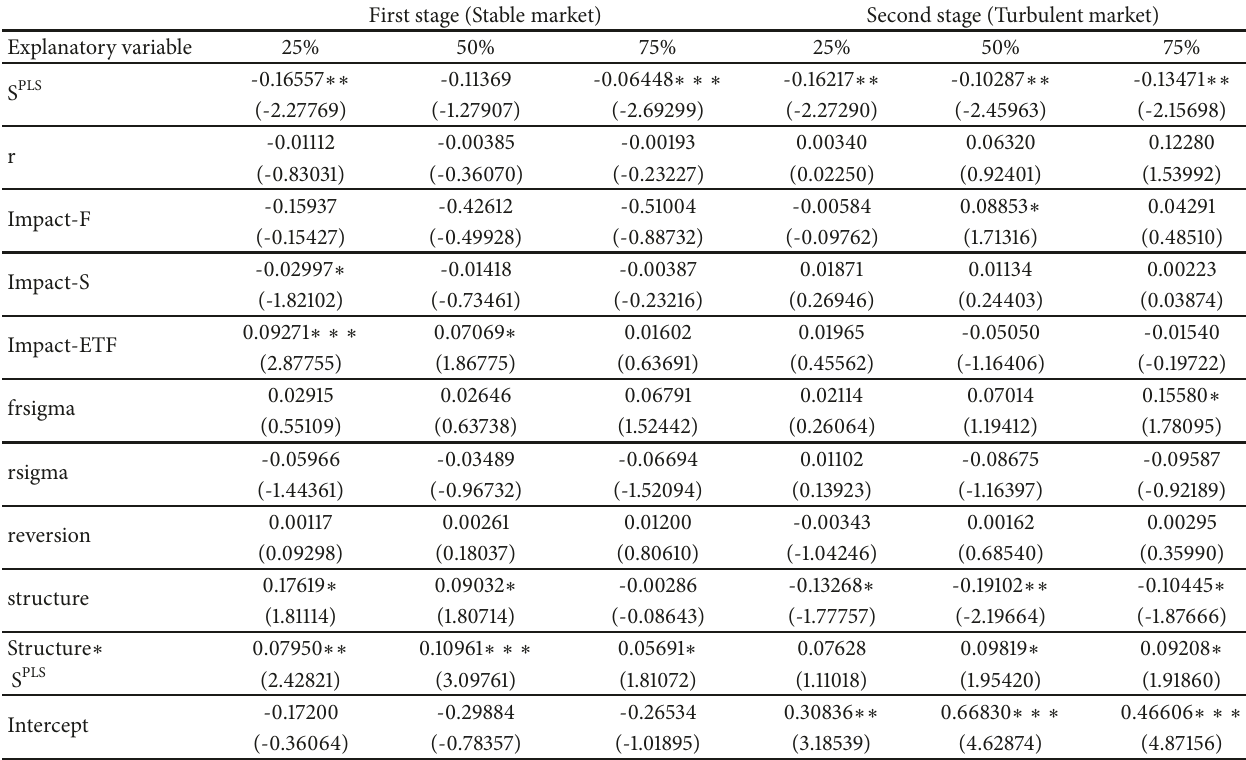
Table 4: Result of the regression estimation based on the control